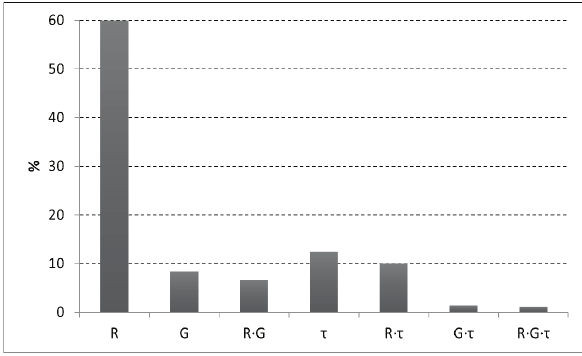
Figure 4: The percentile effect of parameters on the value of K in the Table 7: Input data for the Yates Analysis method.